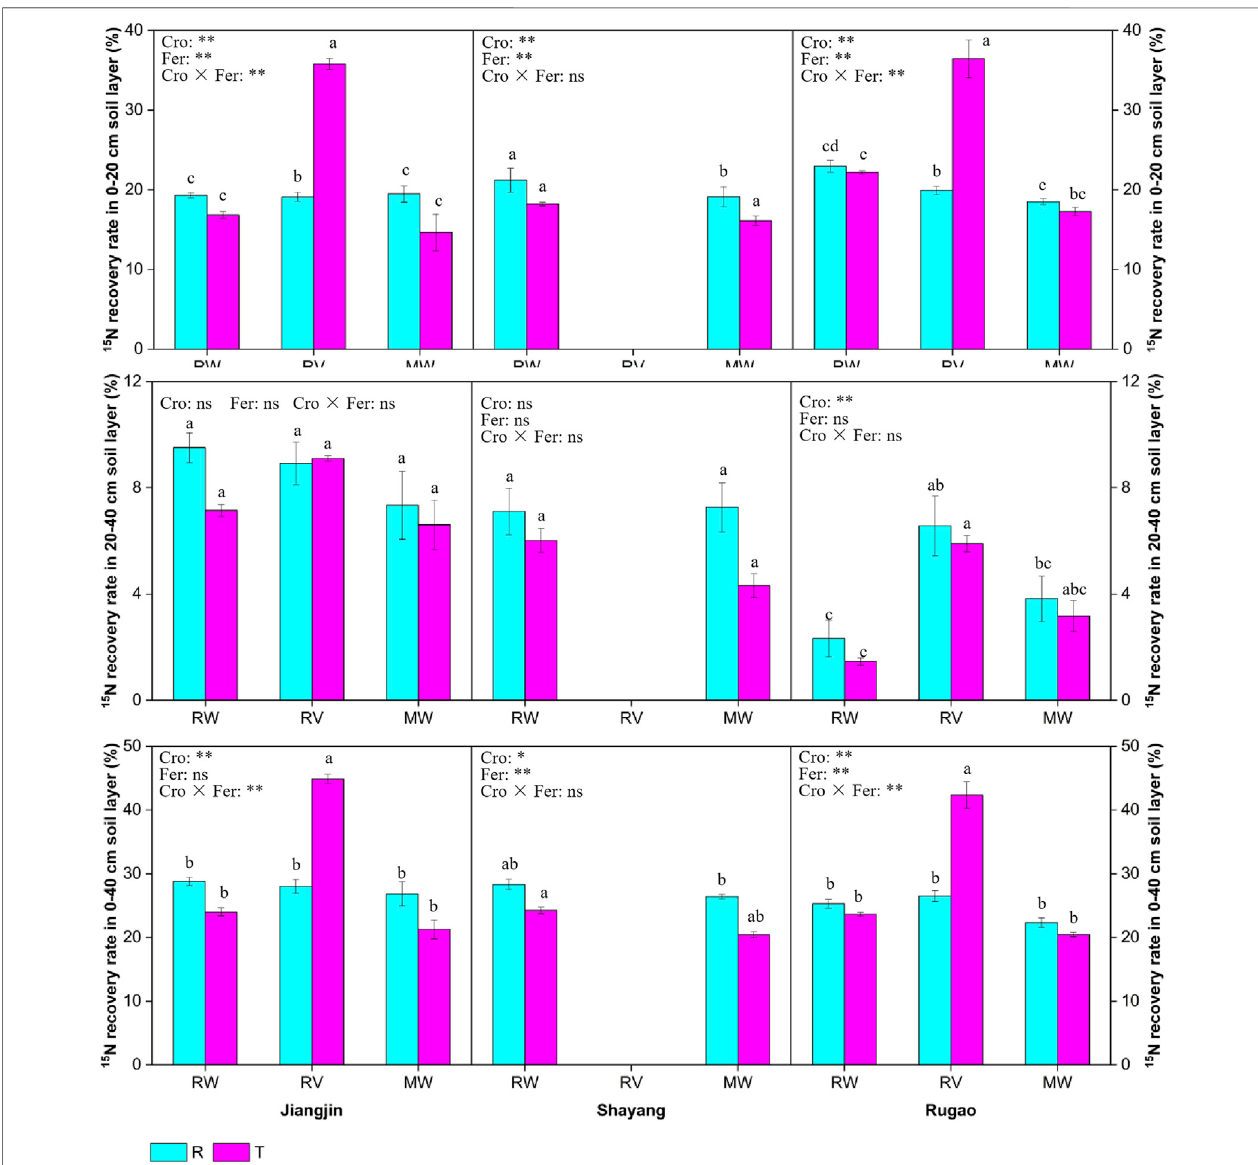
FIGURE 4 | 15 N recovery in the 0 – 40 cm soil layer during the wheat/vegetable season at Jiangjin, Shayang, and Rugao. Note: RW = rice – wheat rotation. RV = rice – vegetable rotation. MW = maize – wheat rotation. Error bars present the standard error of the measurements from three replicates. R = reduced fertilizer input. T = traditional fertilizer input. Different small letters above the bars denote signi fi cance at the 5% level. Cro = crop system. Fer = fertilization. Cro × Fer = the interactions of crop rotation and fertilization. ns, * and ** mean no signi fi cance, p < 0.05 and p < 0.01.